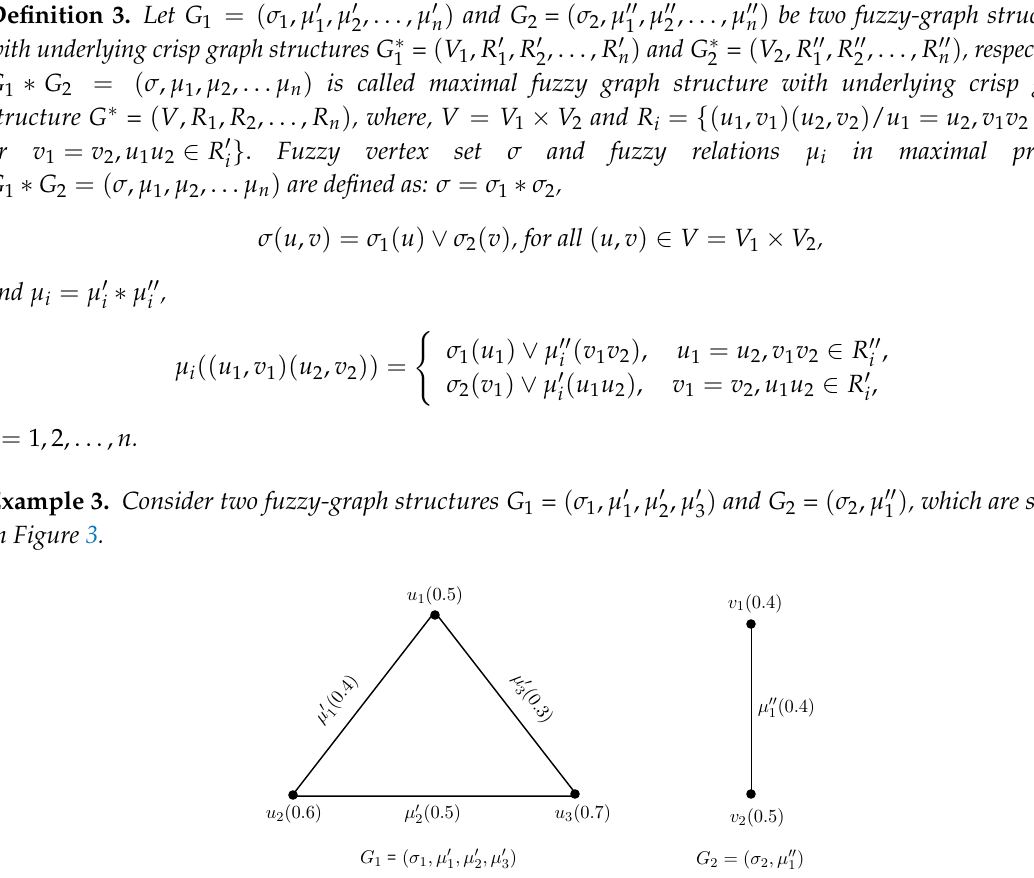
Figure 4: G 1 ∗ G 2 = ( σ, µ 1 , µ 2 , µ 3 ) (Maximal Product) Definition 2.7. A fuzzy graph structure G = ( σ, µ 1 , µ 2 , . . . µ n ) is µ i -strong if 89